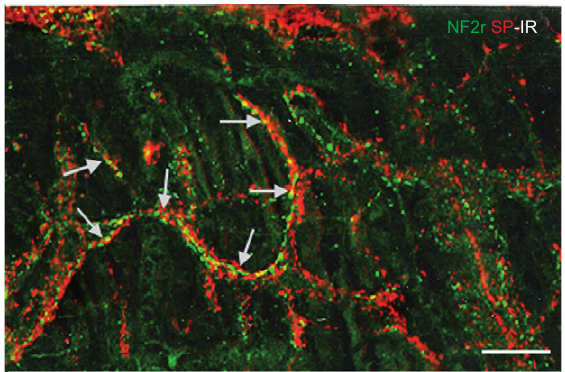
Double labeling with NK2r and SP antibodies (whole mount). Numer- ous NK2r-IR (in green) and SP-IR (in red) varicose fibers at the myen- teric plexus area. Many but not all of the NK2r-IR varicosities overlap the SP-IR ones (arrows). In the background, the spindle-shaped and green-labeled cells are the smooth muscle cells of the LML that are NK2r-IR. Confocal microscope. Calibration bar, 20 μ m [From, Ref. (21), with